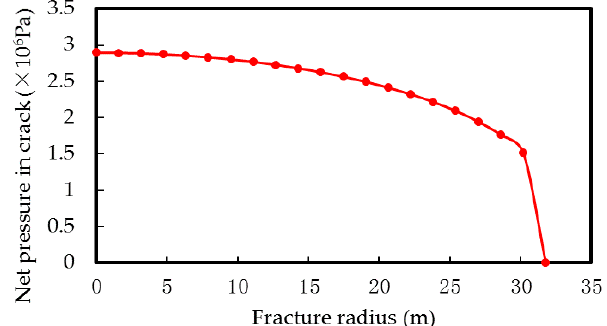
Figure 8. Comparison curves between conventional fracturing and pressure flooding. As shown in Figure 4, in the initial fracture stage, the fracture opens rapidly and expands. With the increase of time, the increase of the fracture radius decreases. The main reason is that with the increase in fracture radius, constant displacement injects fluid, the filtration of fracturing fluid increases, and the volume used for fracturing becomes less and less. As shown in Figure 5, in the initial stage of fracture, the rock opens rapidly, and the maximum height of the fracture reaches 3.4 mm. With the increase of time, the height of the fracture increases slowly, with a small increase from 3.4 mm to 5.3 mm. As shown in Figure 6, the height of each point in the fracture is different, and the height of the fracture in the wellbore is the highest, and gradually decreases to the front of the fracture. As shown in Figure 7, the net pressure of each point in the fracture is different. The net pressure of the fracture in the wellbore is the largest, and the fracture closes gradually near the front.